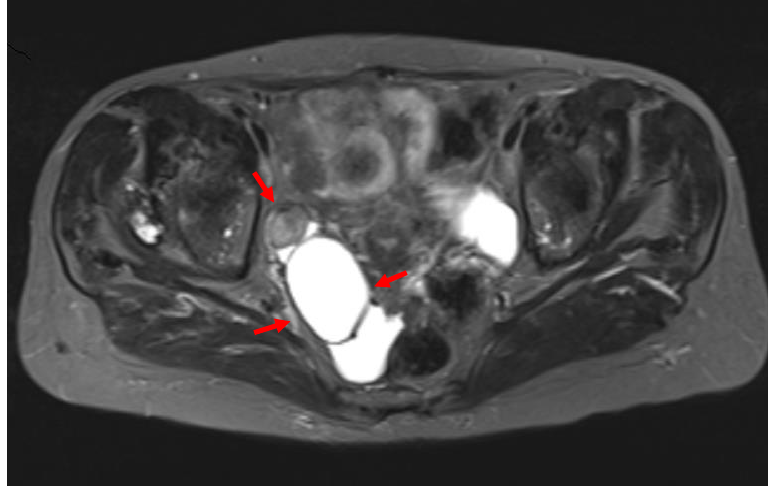
Figure 2. Magnetic resonance imaging of primary carcinoma of the fallopian tube (red arrows), which both preoperatively and intraoperatively was misdiagnosed as a benign ovarian tumor (our